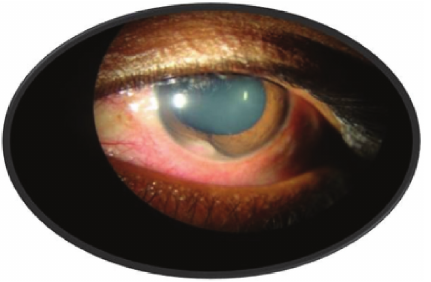
Figure 1: Slit lamp picture of left eye showing mass at 7 o’clock in the periphery of the anterior chamber.